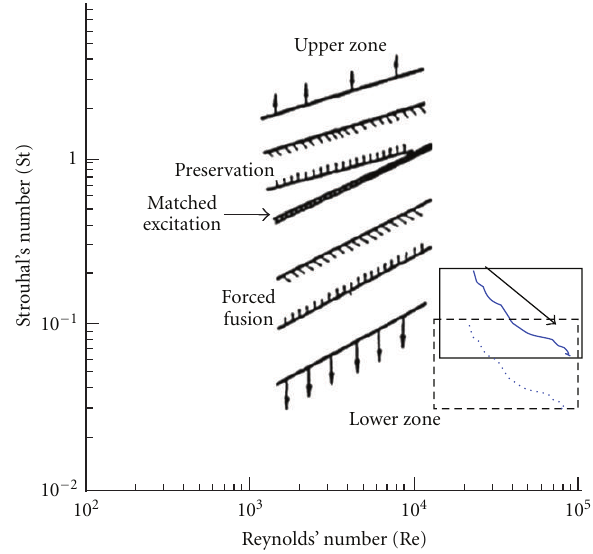
Figure 15: Regimes discussed by Rockwell [37] shown on an excitation Strouhal number versus the jet Reynolds number plot. The small solid rectangle to the right indicates the approximate region in which the Chehroudi LN 2 jet data lies when excitation is at 4800 Hz. The curve within this rectangle shows the approximate path as flow rate is increased from the lowest to the highest values, all at supercritical chamber pressures. Similar region for the 2700 Hz excitation is shown as a dashed rectangle. Chehroudi and Talley